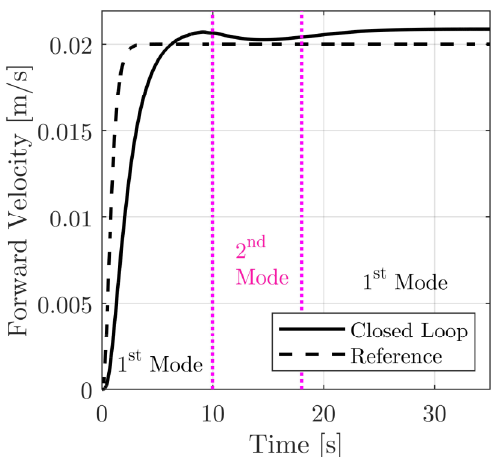
Figure 2. Forward velocity of the vehicle.